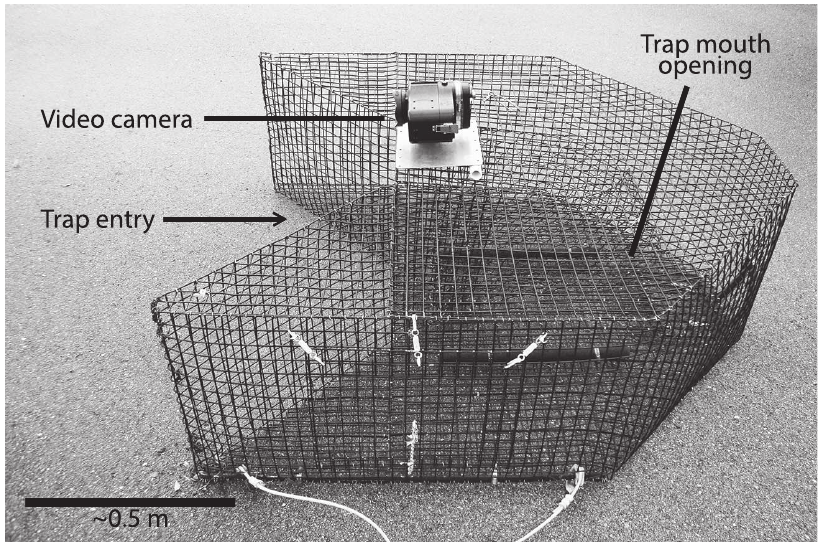
Figure 2. Chevron fish trap outfitted with an outward-looking Canon high-definition video camera over the mouth of the trap.